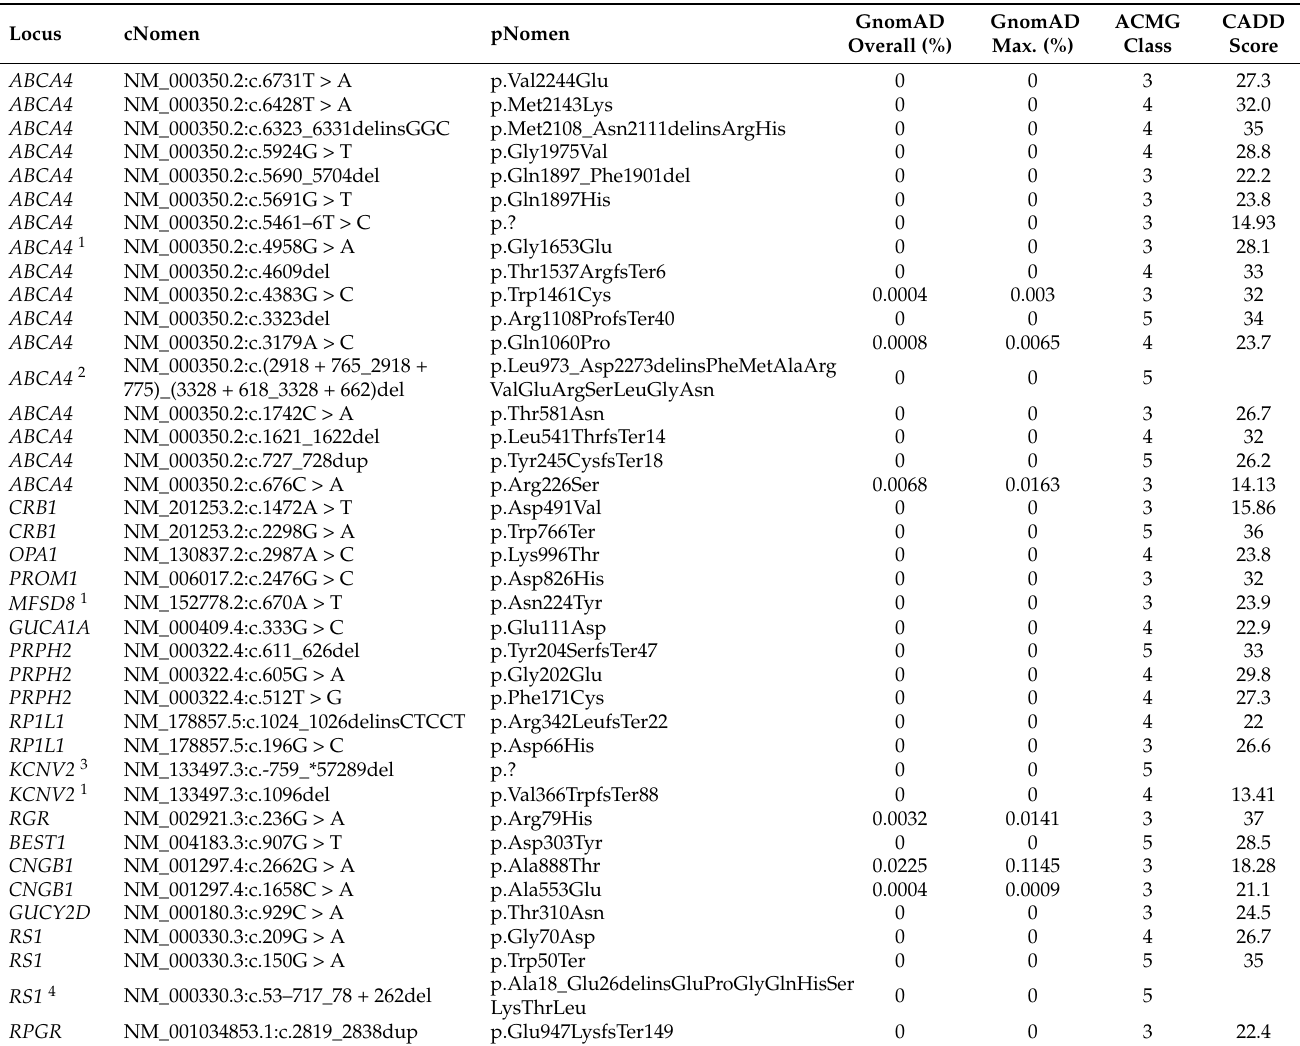
Table 3. Novel likely pathogenic variants. Abbreviations: cNomen, Human Genome Variation Society (HGVS) cDNA-level nucleotide change nomenclature; pNomen, predicted protein-level change nomenclature; gnomAD, genome aggregation database minor allele frequency; ACMG, American College of Medical Genetics and Genomics guidelines; CADD, Combined Annotation-Dependent